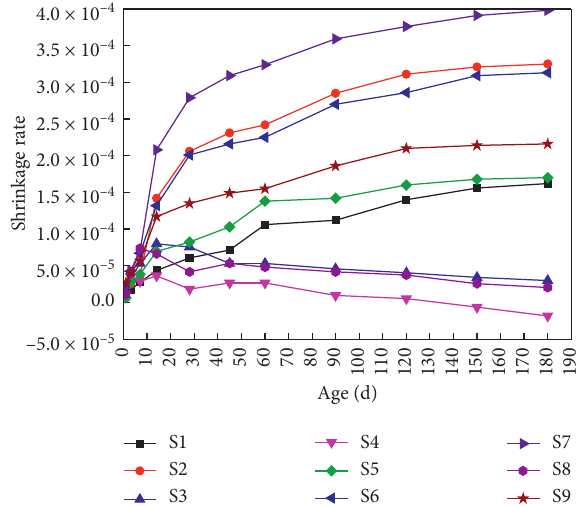
Figure 4: Effects of varying fly ash substitution levels (0, 15, 25, 35, and 45%) on the CFA’s autogenous shrinkage rate under constant temperature (20 ± 2 ° C) and relative humidities (60 ±